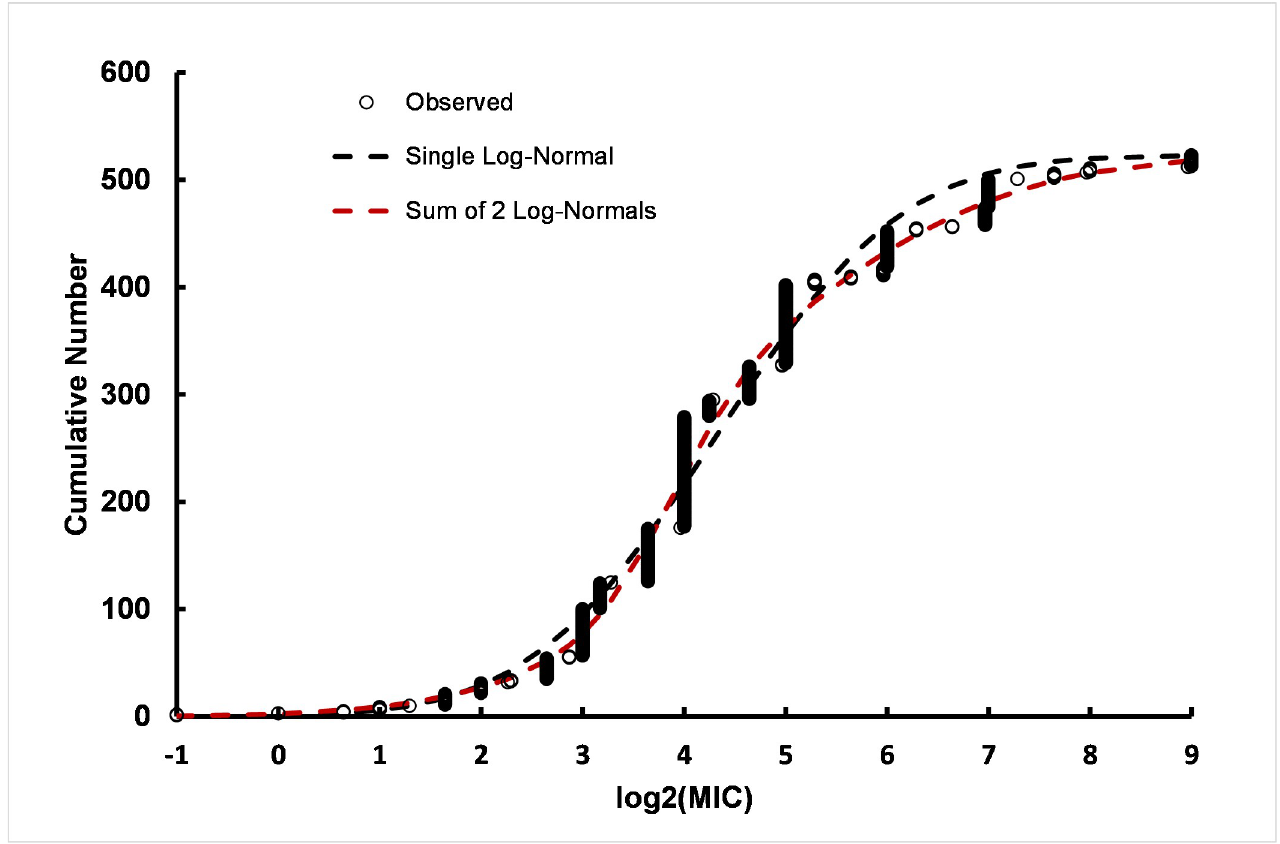
Fig 3. Ps . aeruginosa with single log-normal (black dashed line) and sum of two log-normal distributions (red dashed line) fit to log 2 (MIC)s for 523 strains for all dates. The summary of ten permutation runs is provided in S2 Table in S2